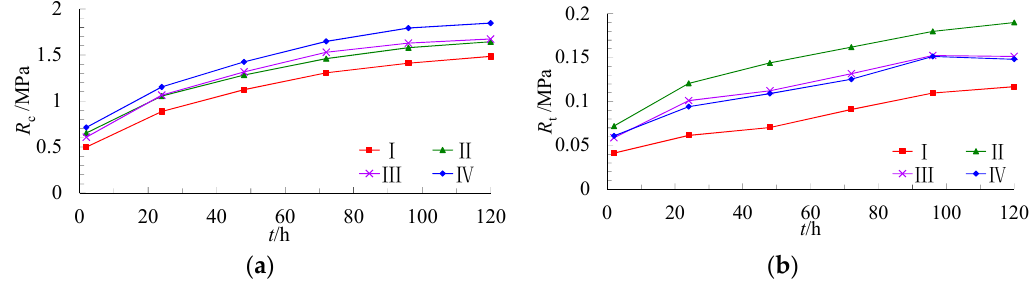
Figure 9. Strength change characteristics of specimens at curing time. ( a ) Compressive strength; ( b ) Tensile strength.